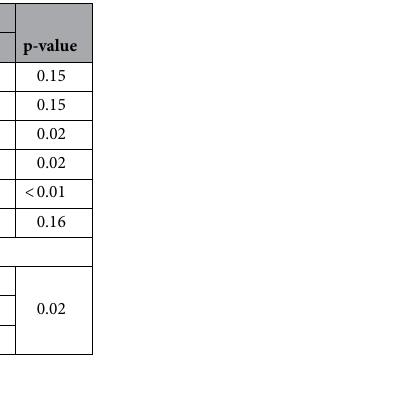
Table 1. Baseline characteristics of drusen